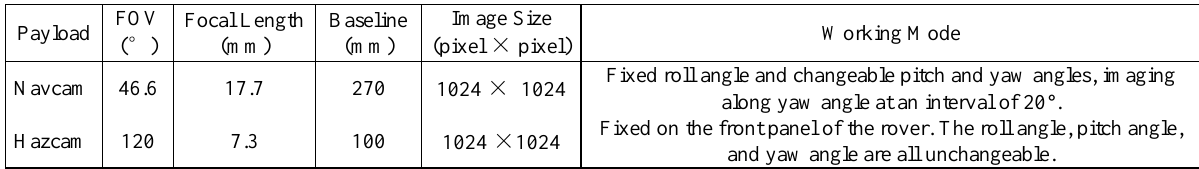
Fixed on the front panel of the rover. The roll angle, pitch angle, and yaw angle are all unchangeable. Table 1. Basic parameters of Navcam and Hazcam (Chen et al, 2014)